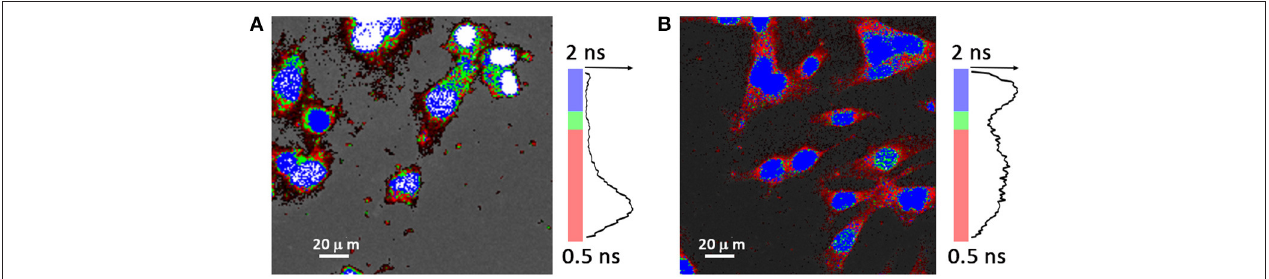
FIGURE 10 | FLIM images showing cell uptake of DSPC:DODAP (2:1) nanocarriers loaded with Daunorubicin (0.5 µ M) using HeLa cells after (A) 15min of incubation and (B) 4h of incubation. In the image no membrane dye was employed and a false color range (0.5–2.0 ns) was used according to the fluorescence lifetimes measured. Blue color corresponds to the longer lifetime ( ∼ 2 ns), while green color corresponds to intermediate lifetime ( ∼ 1.5 ns) and red color corresponds to shorter lifetimes ( ∼ 0.5 ns). Fluorescence intensity histogram is represented along side the respective lifetime color bar.